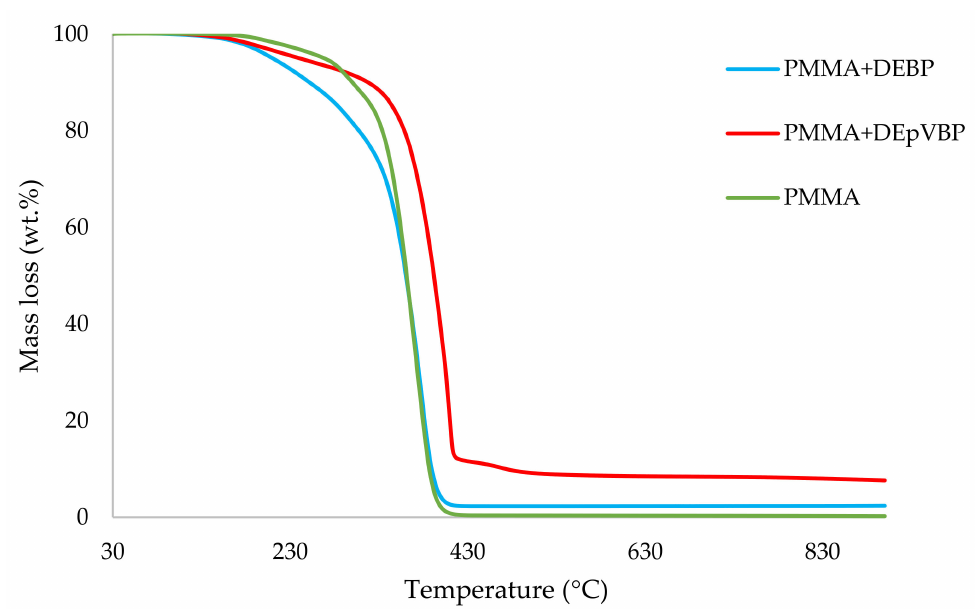
Figure 5. An overlay of the TGA curves of PMMA and PMMA + aromatic phosphonate materials.